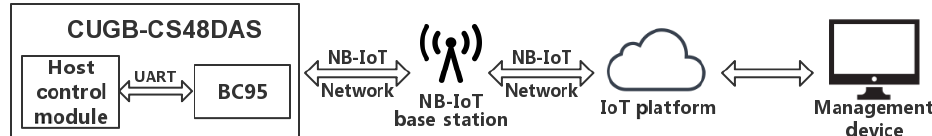
Figure 10. Connection to the internet of